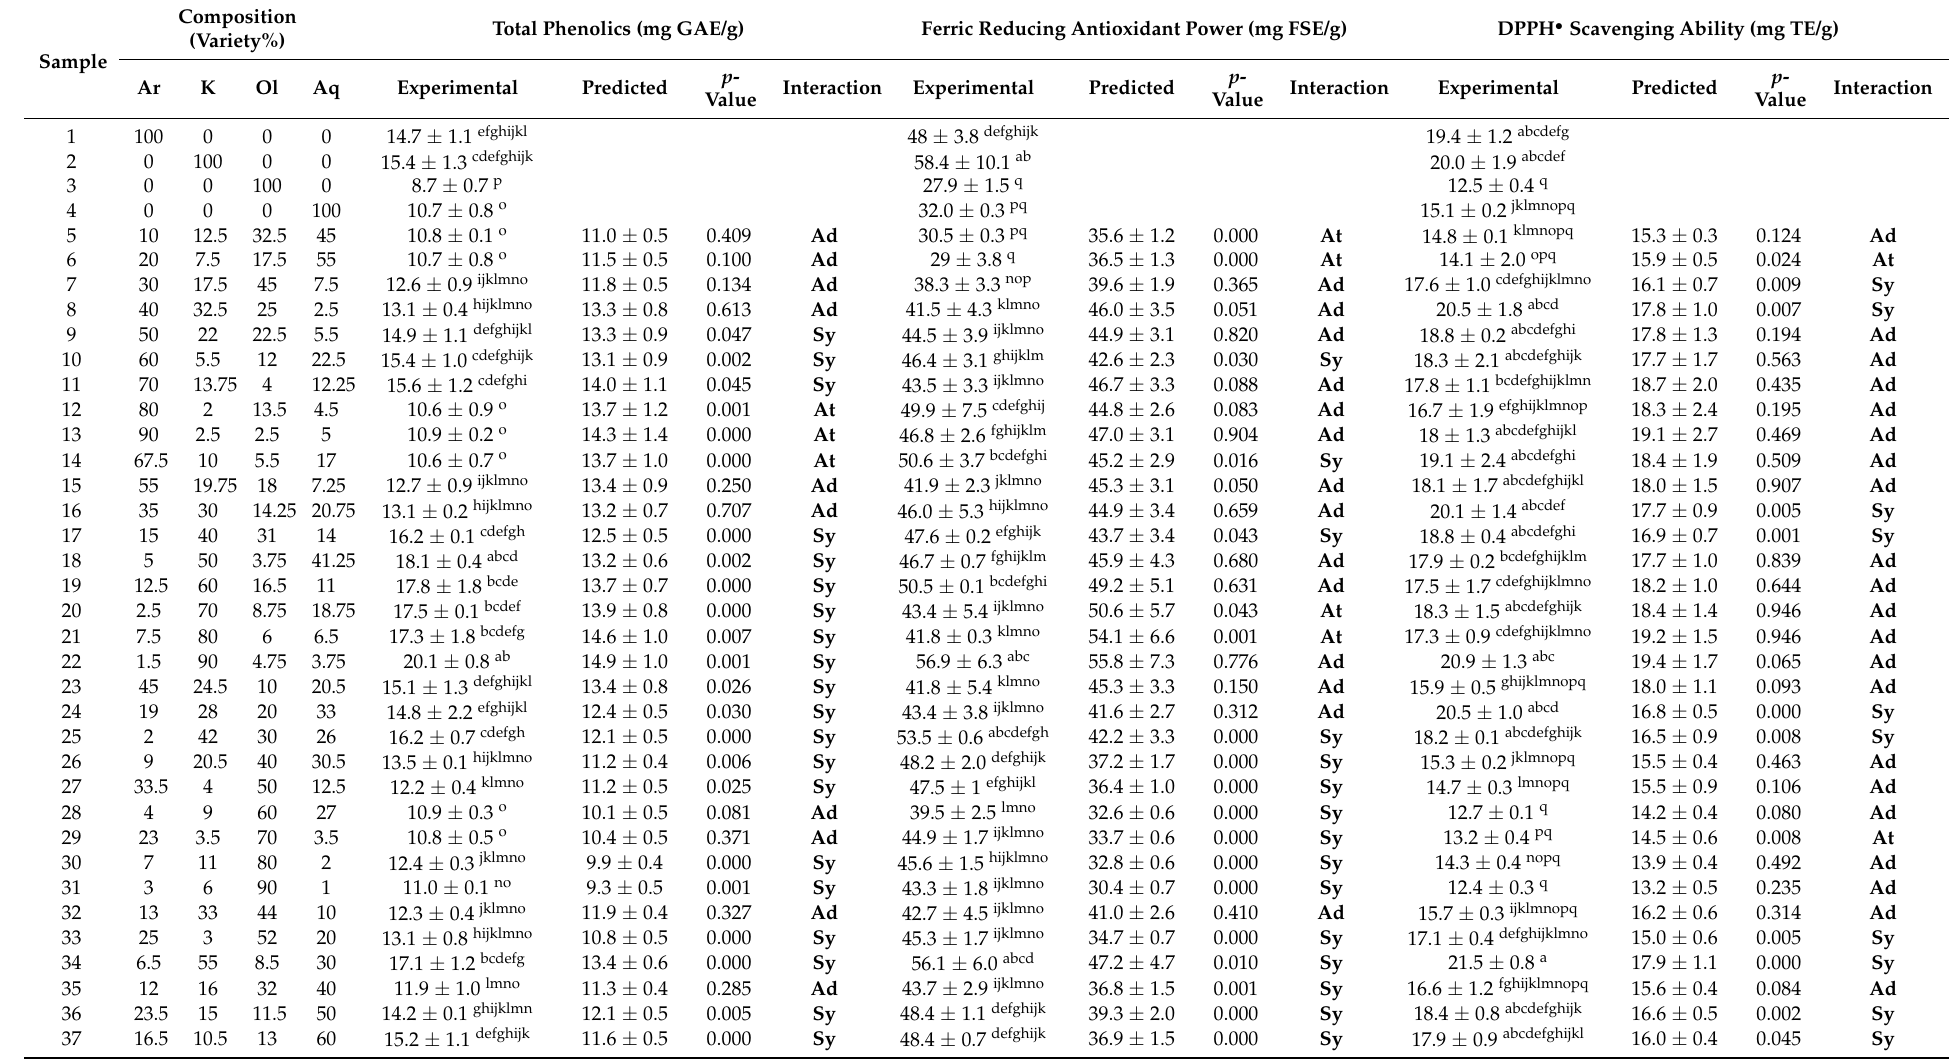
Table 1. Total phenolics contents and antioxidant activity of monocultivar olive pomaces and blends. Experimental, predicted results, and